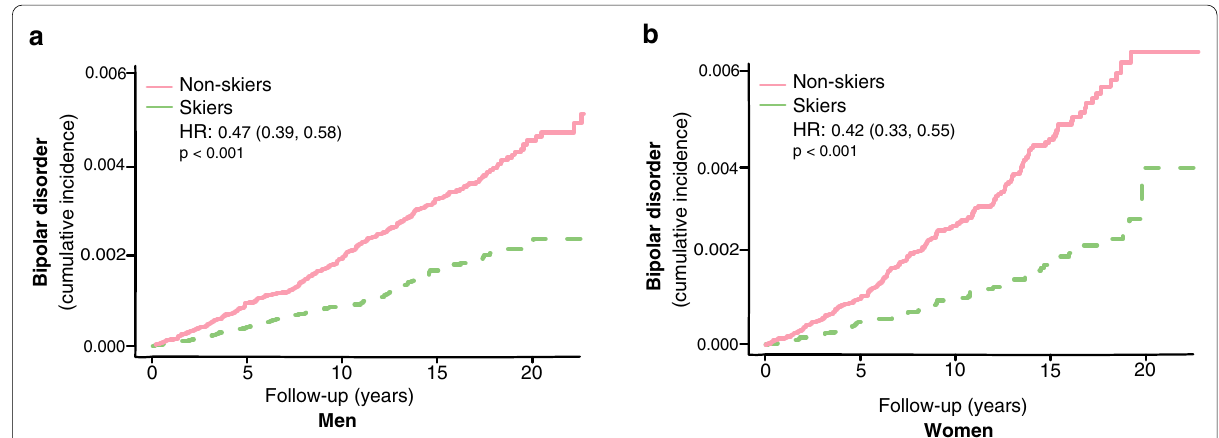
Fig. 2 The risk of developing bipolar disorders in skiers compared to non-skiers in men ( a ) and women separately ( b ). HR represents hazard ratios from an unadjusted C ox regression